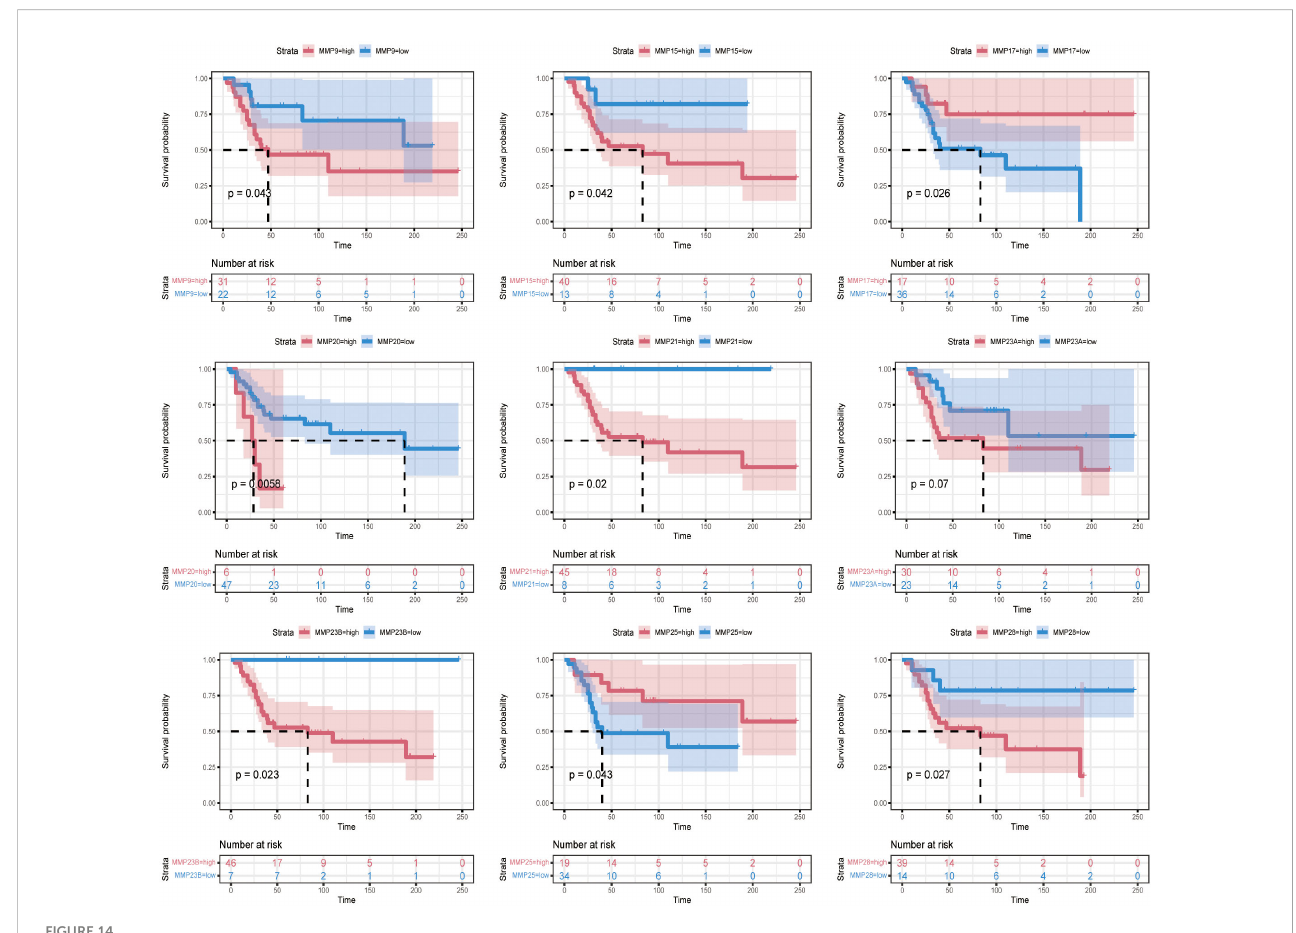
FIGURE 14 Association between the MMPs expression and the prognosis of